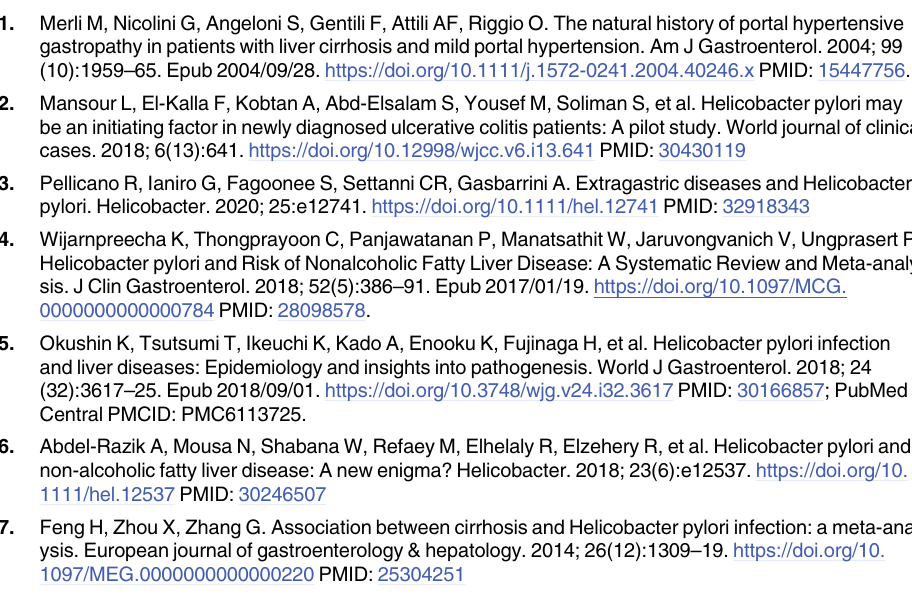
S3 Table. Sensitivity analysis. S4 Table. PRISMA